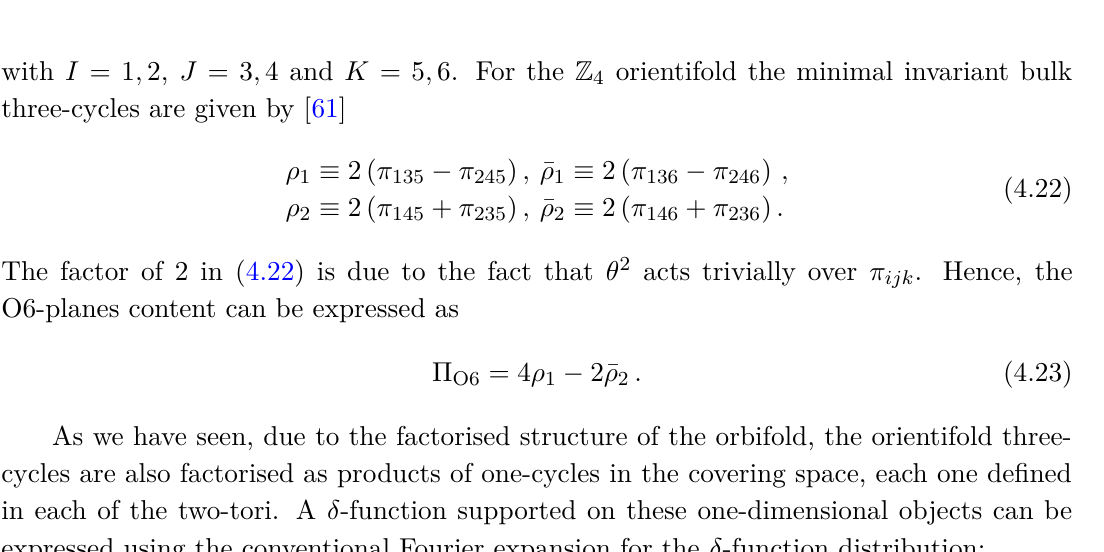
Figure 4. Orientifold planes projected over T 2 × T 2 × T 2 in the Z 4 orbifold. Planes Π R , Π 1 , Π 2 , Π are represented by the colours red, pink, green and blue 3